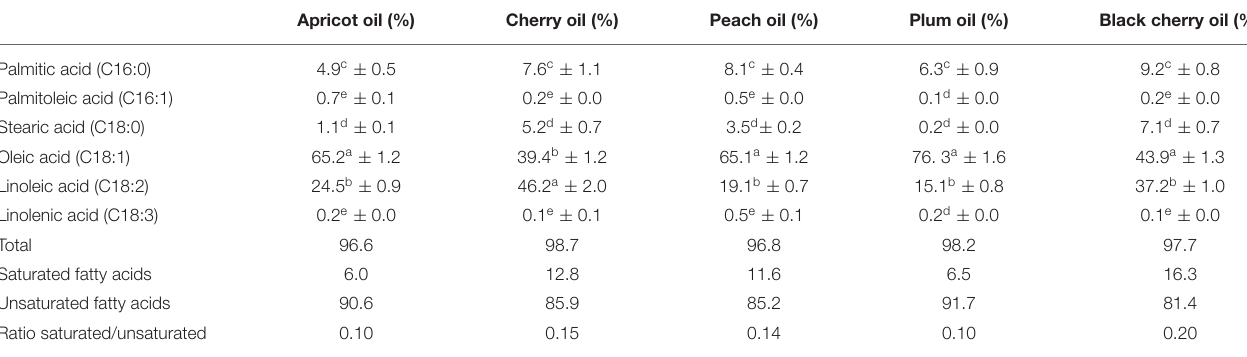
TABLE 1 | Fatty acid composition of the cold-pressed seed oils of apricot, cherry, peach, plum, and black cherry*. Apricot oil (%) Cherry oil (%) Peach oil